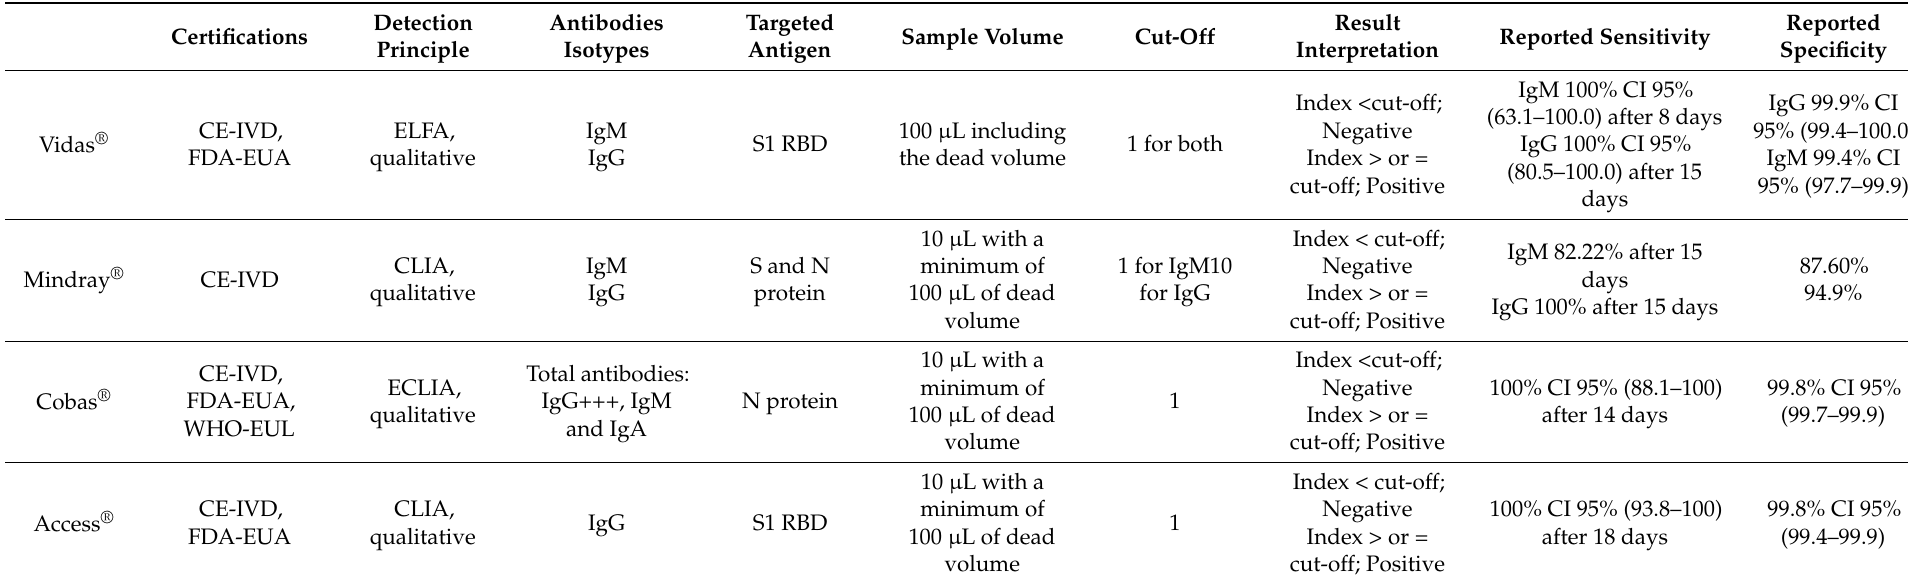
Table 1. Characteristics of the four evaluated commercial serology tests according to the manufacturer’s